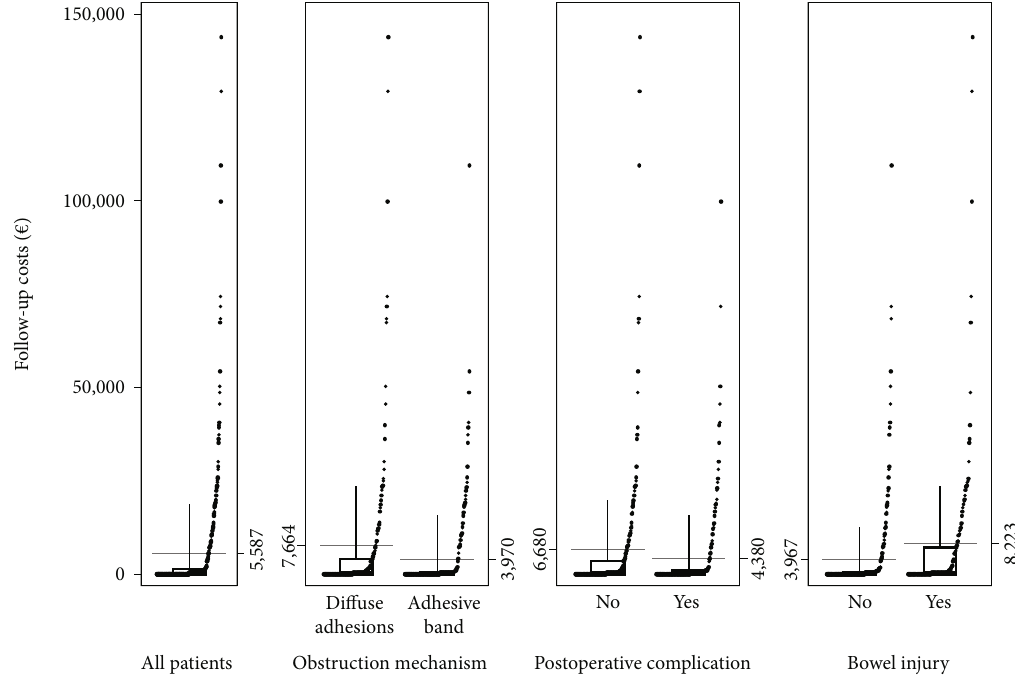
Figure 2: Total costs ( € ) for index SBO-surgery and the follow-up period. Data are presented for all patients and separately strati fi ed by mechanism of obstruction, bowel injury, and postoperative complication. Numbers on the sides of the graphs represent mean cost per